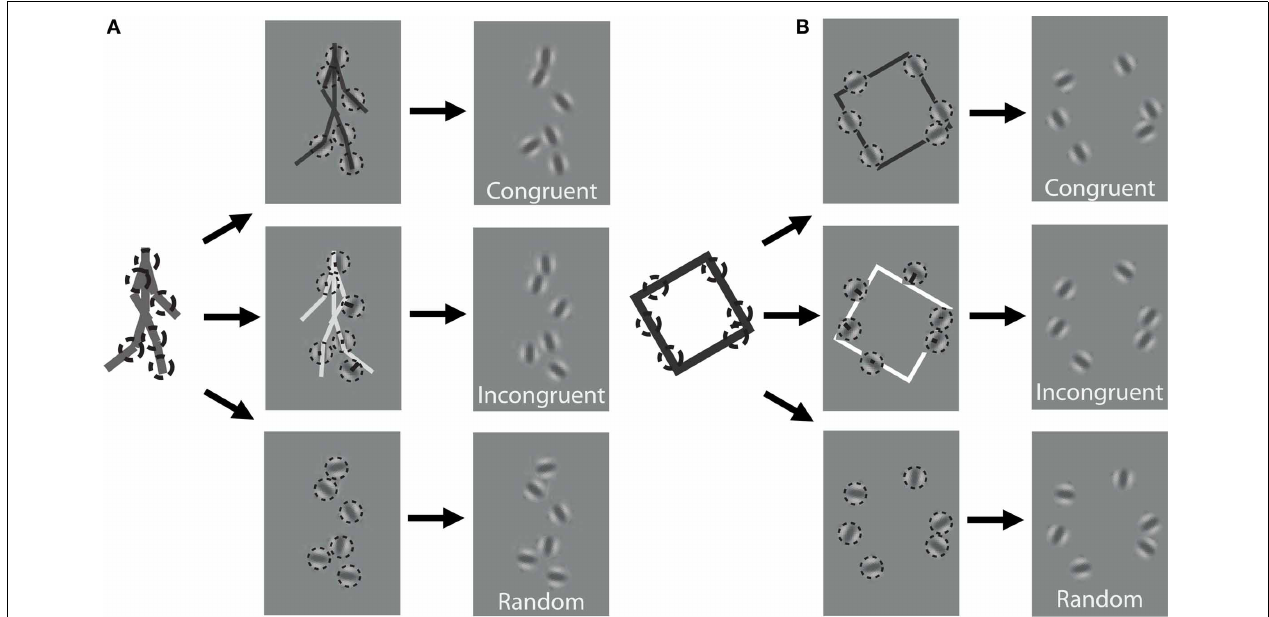
FIGURE 1 | Schematic of stimulus construction for biological (A) and non-biological (B) stimuli. The left of each panel shows a single static frame from the animation sequence and an example of 6 random spatial samples denoted by dotted circles. The middle panels show the extraction of orientation from the nearest line segment of the stick figure for a congruent (top) and incongruent (middle) stimulus, as well as a random orientation